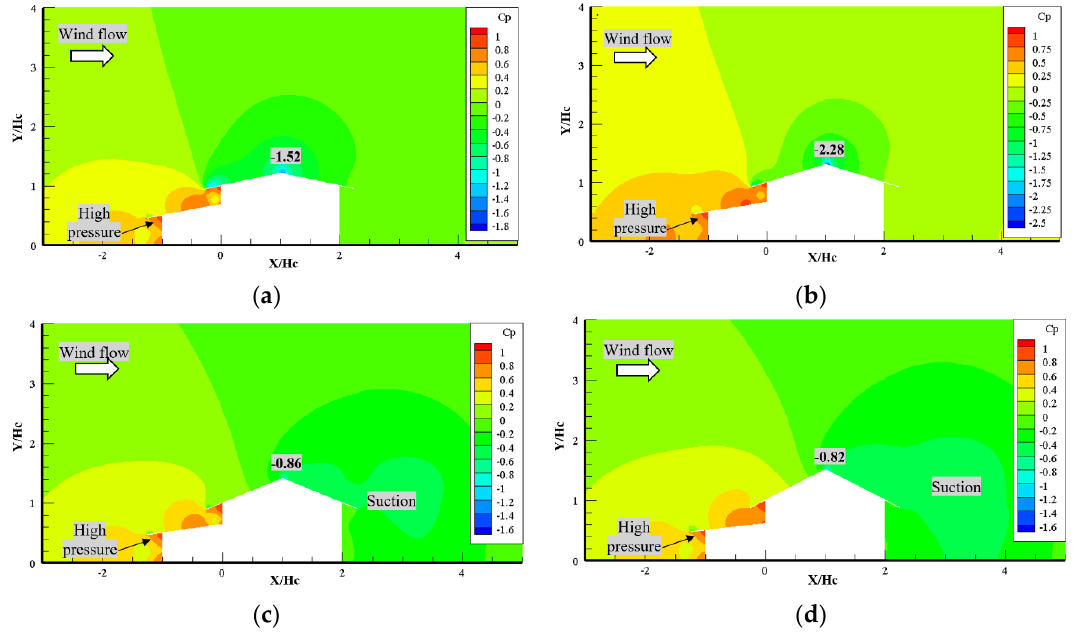
Figure 17. The pressure coefficient contours for model with kitchen at the center with a roof pitch of ( a ) 12°; ( b ) 17°; ( c ) 22°; and ( d ) 27°.